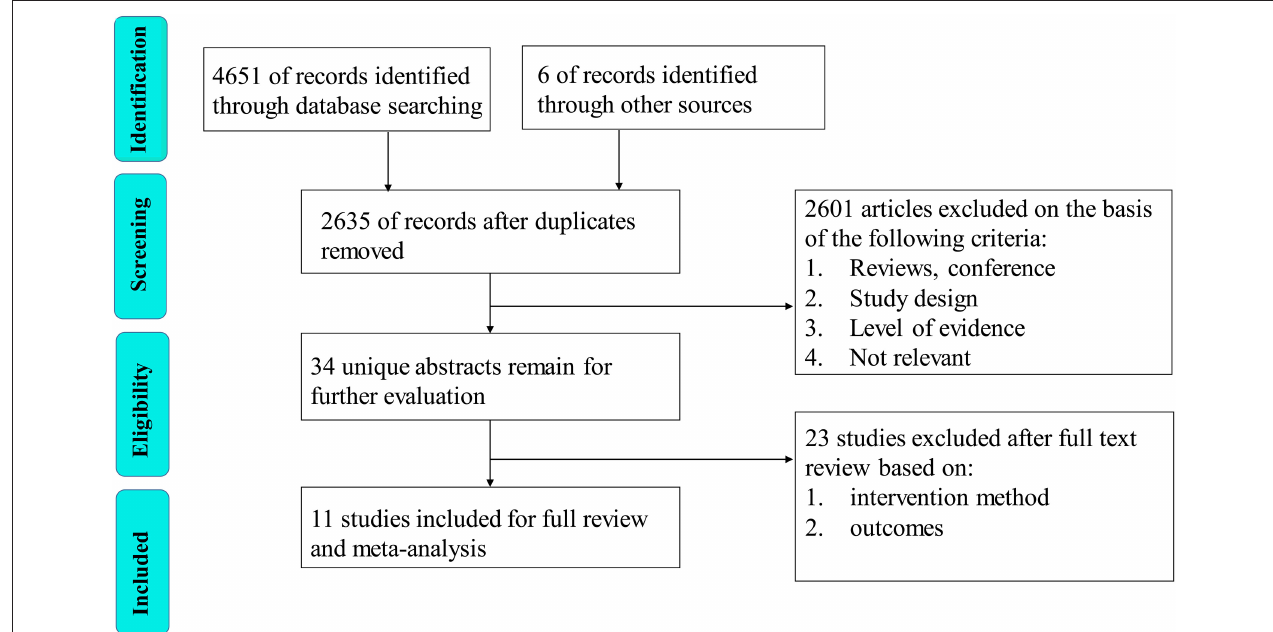
FIGURE 1 | The literature selection